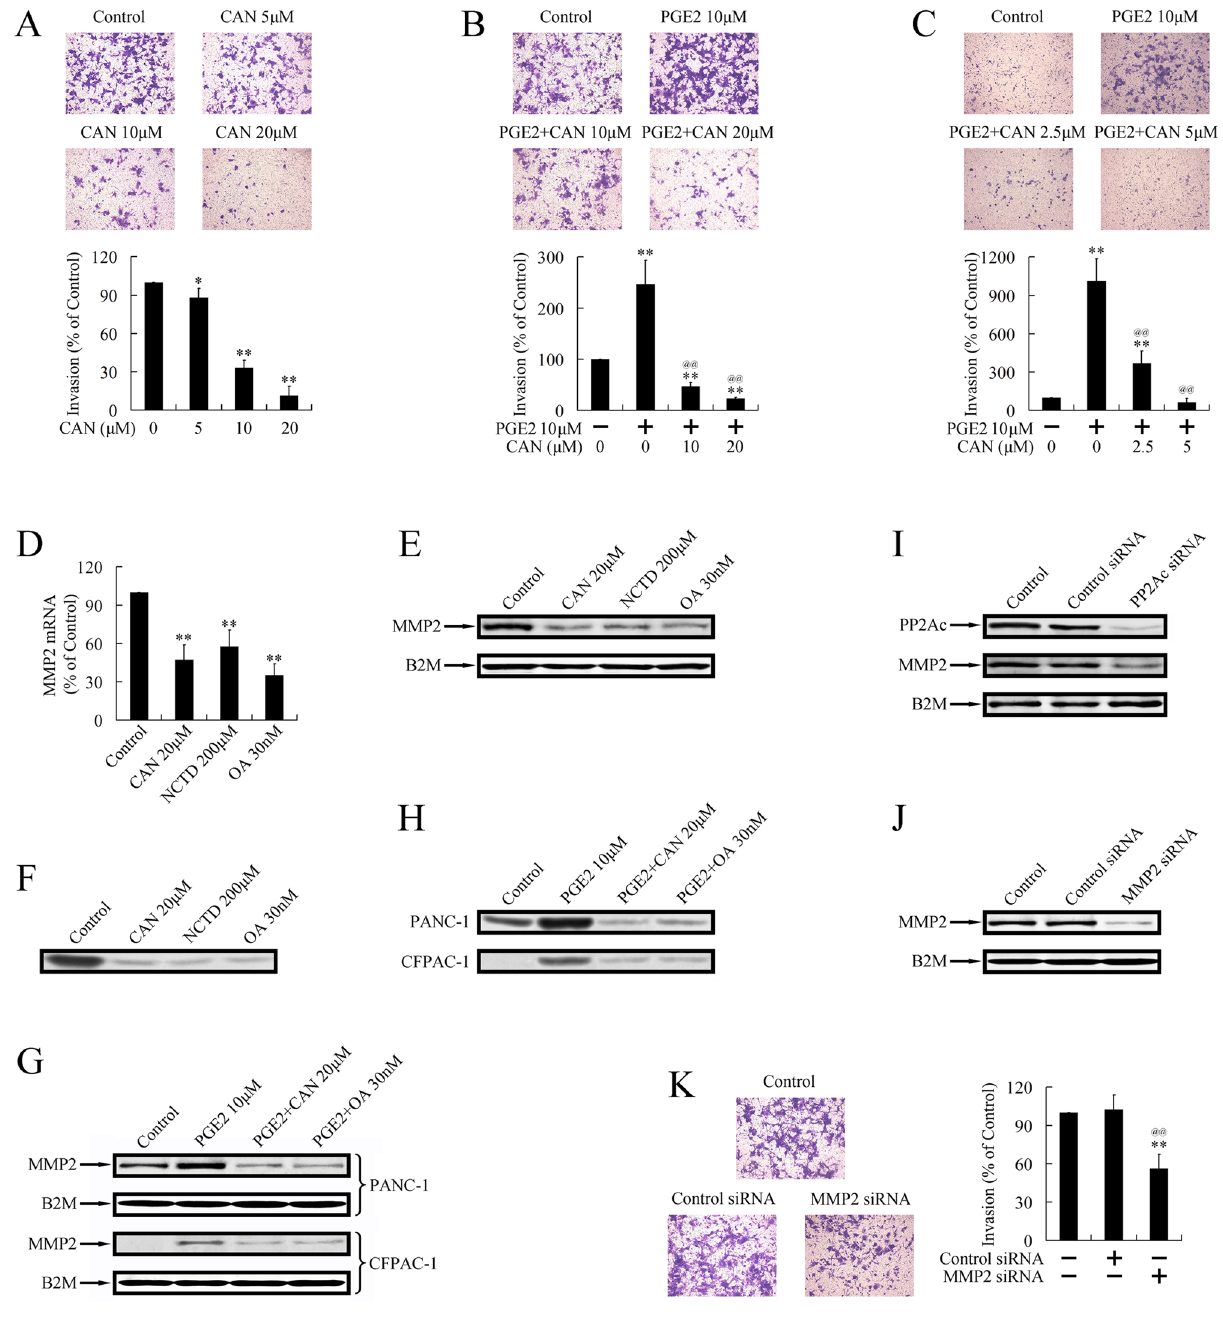
Figure 1. A correct version of the original Figure